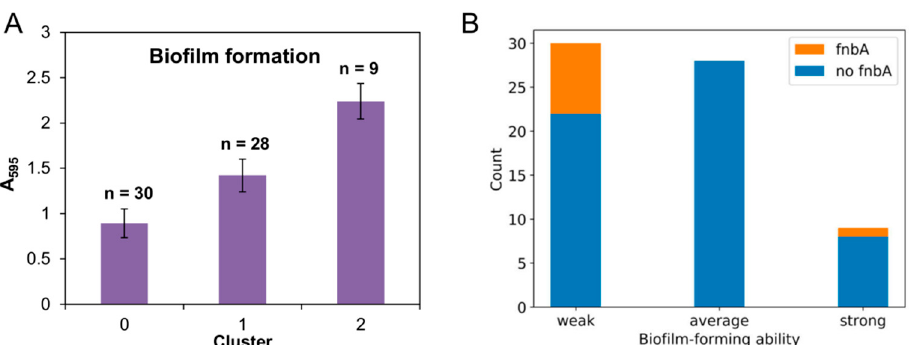
Figure 4. Biofilm formation of clinical MRSA isolates. ( A ) Clustering of MRSA strains based on their biofilm-forming abilities into weak (cluster 0), average (cluster 1) and strong (cluster 2) biofilm formers. The graphs represent the means ± standard deviation of the values corresponding to each group, indicating the number of strains that belong to each cluster. ( B ) Stacked bar chart representing the number of strains for each cluster that carry gene fnbA (orange) and those that do not (blue).